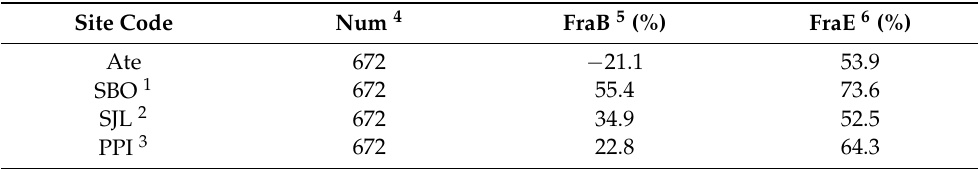
Table 2. Hourly PM 2.5 concentrations for the stations predicted using the WRF-Chem model for case-control. Site Code Num 4